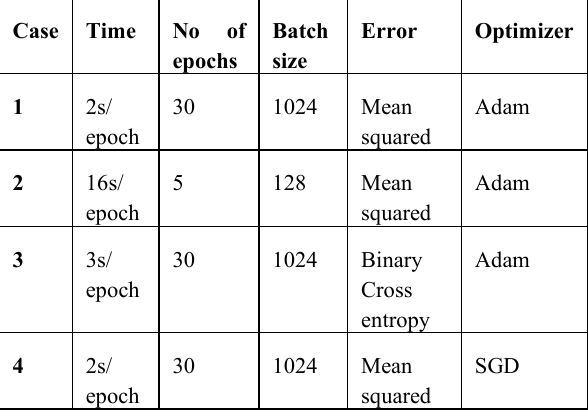
Table 1. Various cases under Neural